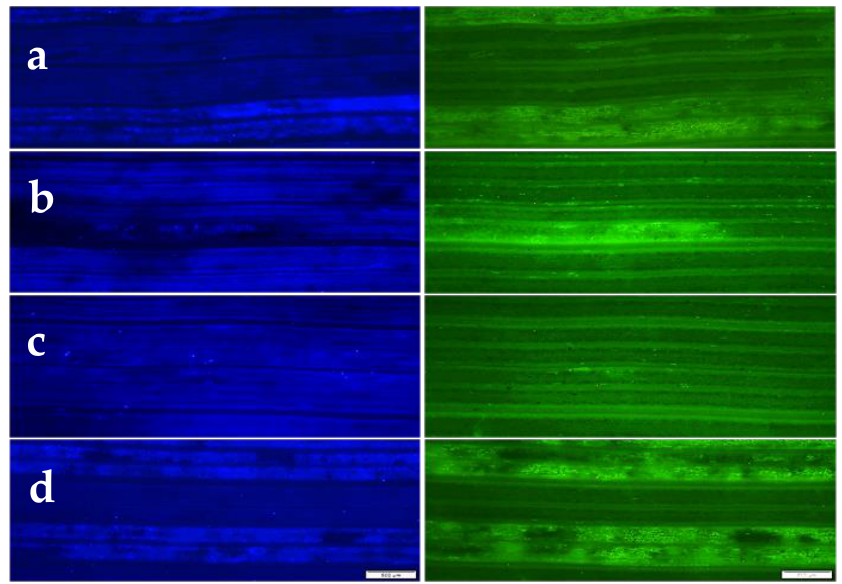
Figure 1. Microscopic images of flag leave segments from the first sampling, showing fluoresced Puccinia striiformis f. sp. tritici race 6E22A+ colonies (left panel) and associated host cell necrosis (right panel) in parents ( a ) Palmiet and ( b ) Yr16DH70, and recombinant inbred lines containing resistance quantitative trait loci on chromosome(s) ( c ) 2A+2D and ( d ) none. Scale bars represent 500 µm.